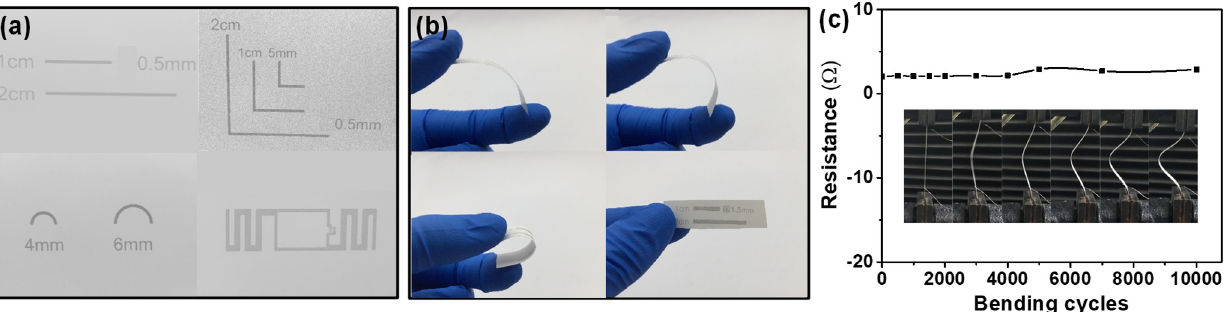
Figure 10. ( a ) Different shapes of electrodes prepared by screen printing with silver paste on paper. ( b ) Photographs of linear screen-printed silver electrodes bended at angles of 45°, 90°, 180° and recovered. ( c ) Resistance changes of linear screen-printed silver electrodes at angle of 45° bended for 10,000 times.